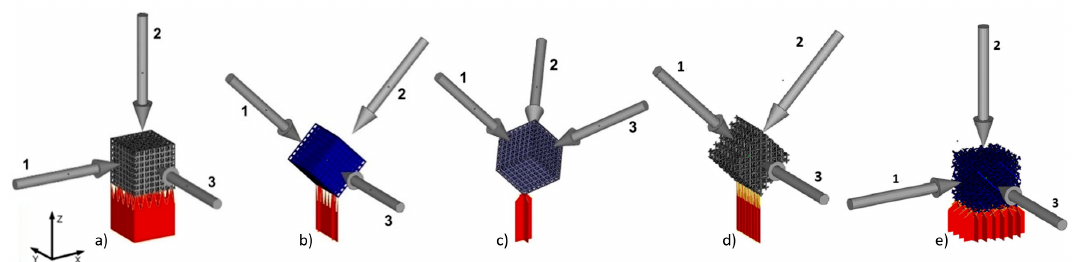
Figure 4. BFS models for analysis and manufactured sample orientation relative to the build platform and marked loading directions for individual samples: ( a ) A1, ( b ) A2, ( c ) A3, ( d ) type B, ( e ) type C.